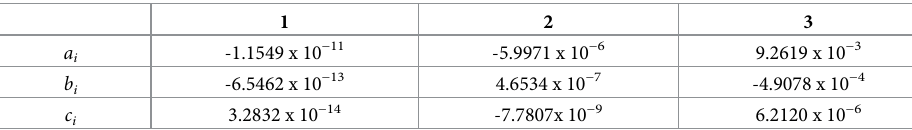
Table 2. Coefficients of the calculated response